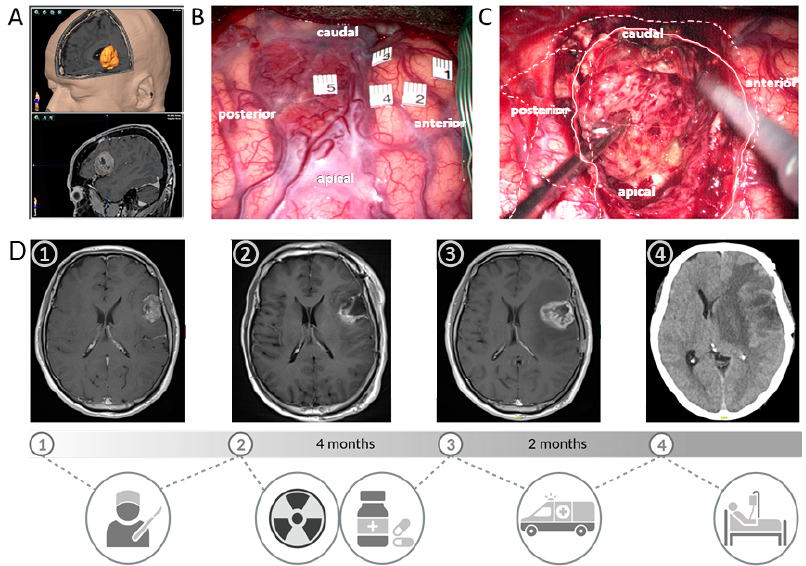
Figure 2. This case of a patient with a mesenchymal GBM highlights the unfavourable clinical course compared to other subtypes impressively. A 42-year-old male patient presenting with seizures demonstrated a contrast-enhancing lesion in Broca’s left-sided area on MRI ( A , D ) and bilateral activation by functional MRI. Awake craniotomy with cortical ( B ) and subcortical mapping was scheduled due to the highly eloquent localisation of the tumour, which was both clearly visible on the brain surface ( B ) and subcortically ( C ) with typical necrotic tissue and pathological vessels. Here, 86% of the contrast-enhancing lesion was resected ( D , first to the second picture), as quantified by MRI volumetry, while a total resection was not feasible due to close eloquent subcortical pathways as demonstrated by bipolar electrical stimulation intraoperatively. Postoperatively, the patient suffered from dysphasia. Radiotherapy (60 Gy) and TMZ therapy were simultaneously administered and discontinued after radiotherapy by the patient himself. Only 4 months after surgery, the patient developed progressive dysphasia and hemiparesis ( D , third picture). A second surgery was not considered to be feasible, and chemotherapy, according to Stupp’s protocol, was administered together with TTFields. However, the patient again presented an emergency admission with rapid clinical and radiological progression 2 months later ( D , fourth picture). Lacking alternatives, palliative care was initiated. Created with BioRender (OI2349TKM9, 25 October 2021).